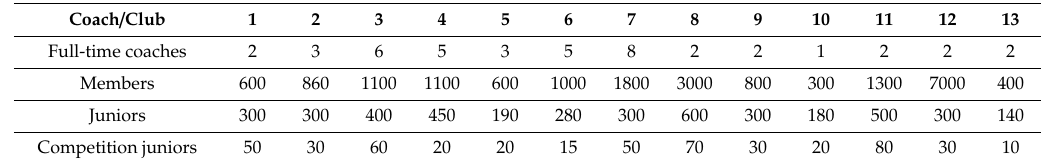
Table 1. The number of full-time tennis coaches, members, juniors, and competition juniors in participating coaches’